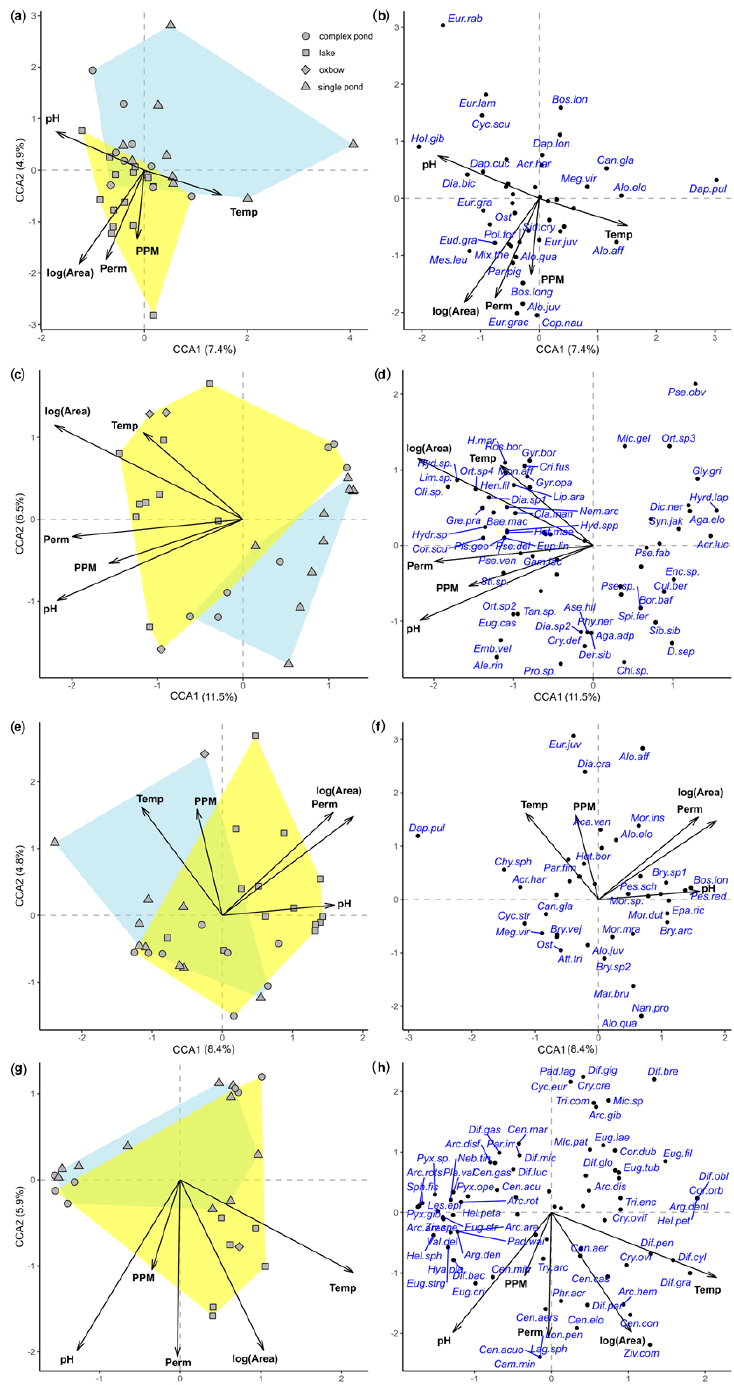
Figure 4. CCA ordination illustrating the variation in species structure of zooplankton ( a , b ), macro- ( c , d ) and meio- ( e , f ) and microbenthos ( g , h ) in various types of waterbodies in the Lena River Delta: ( a , c , e , g ) are distance plots of site scores demonstrating patterns in relation to water temperature (Temp), acidity (pH), mineralization (PPM), permafrost depth (Perm) and log-transformed area (log (Area)); polygons encircle the samples from the water bodies with (blue) and without fish (yellow); ( b , d , f , h ) are species plots (see Supplementary Materials, Table S6 for species abbreviations); only species with a contribution greater than 0.7 (absolute value) to at least one of the axes are labeled on the plot to improve the